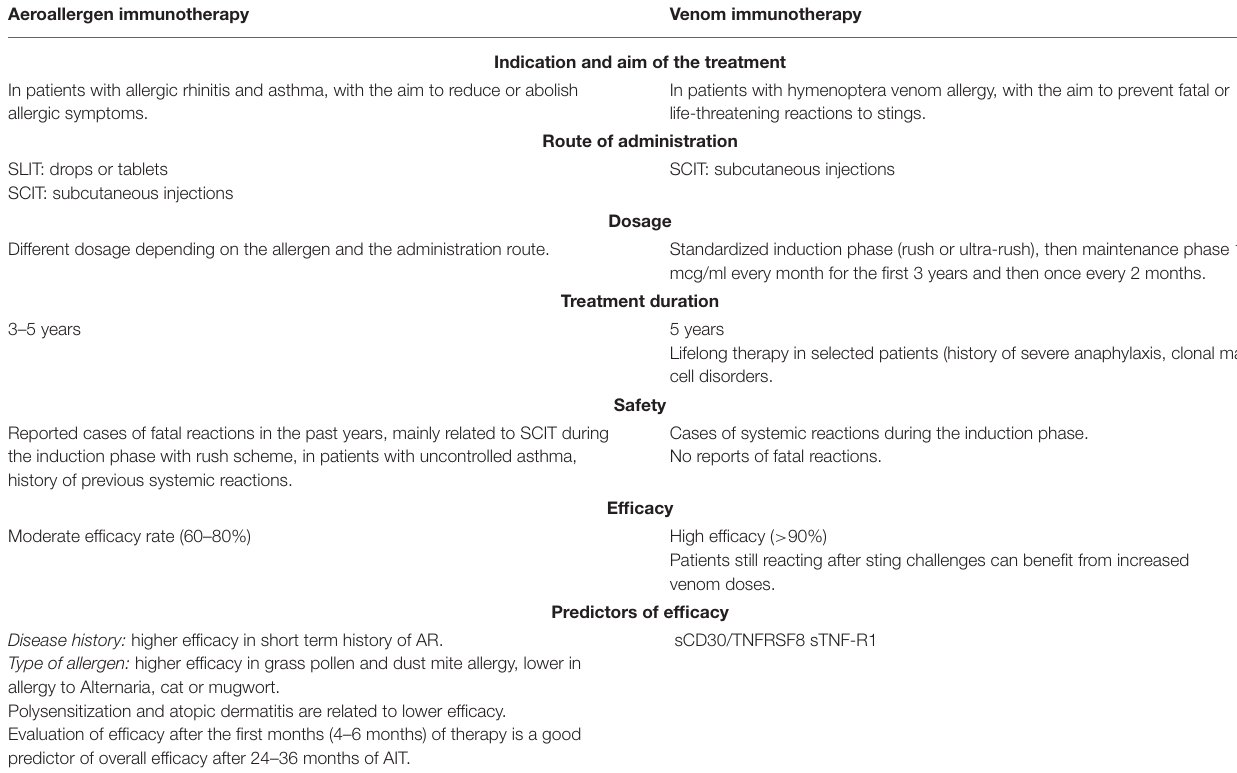
TABLE 1 | Features of AIT and VIT. Aeroallergen immunotherapy Venom immunotherapy